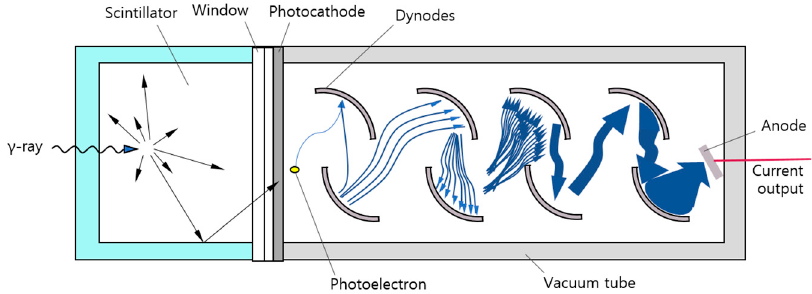
Figure 2. Basic composition of the scintillation detector.